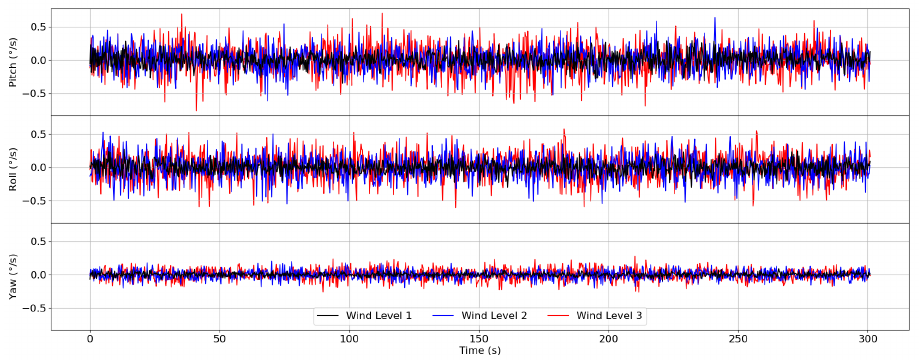
Figure 9. Comparison of DJI M600 angular rates.